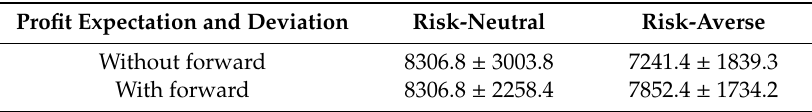
Figure 12. Comparison of r (cid:2869)∗ , 𝑟 (cid:2870)∗ , and 𝑟 (cid:2872)∗∗ from Theorems 1, 2, and 4 as a function of the demand slope b (left panel), and θ (cid:2872)∗∗ and 𝜃 (cid:2871)∗ from Theorems 4 and 3 as a function of the demand slope b (right panel).